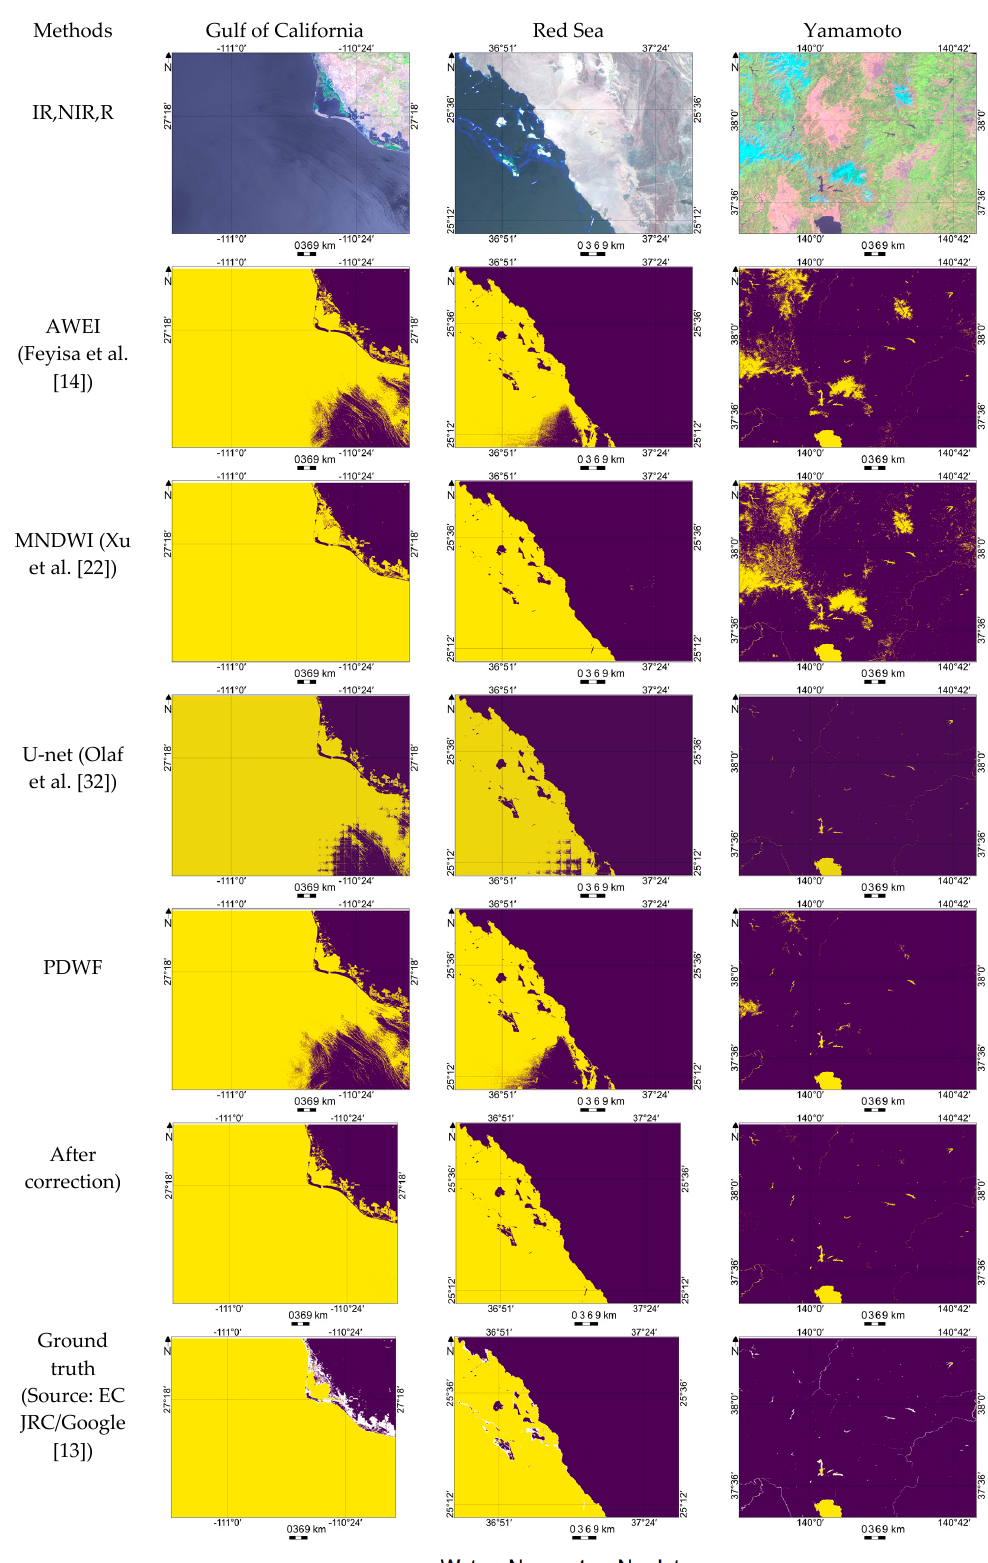
Figure 6. Detailed demonstration of water/non-water region estimation results derived from various methods on sunglint-affected and snow/ice-covered